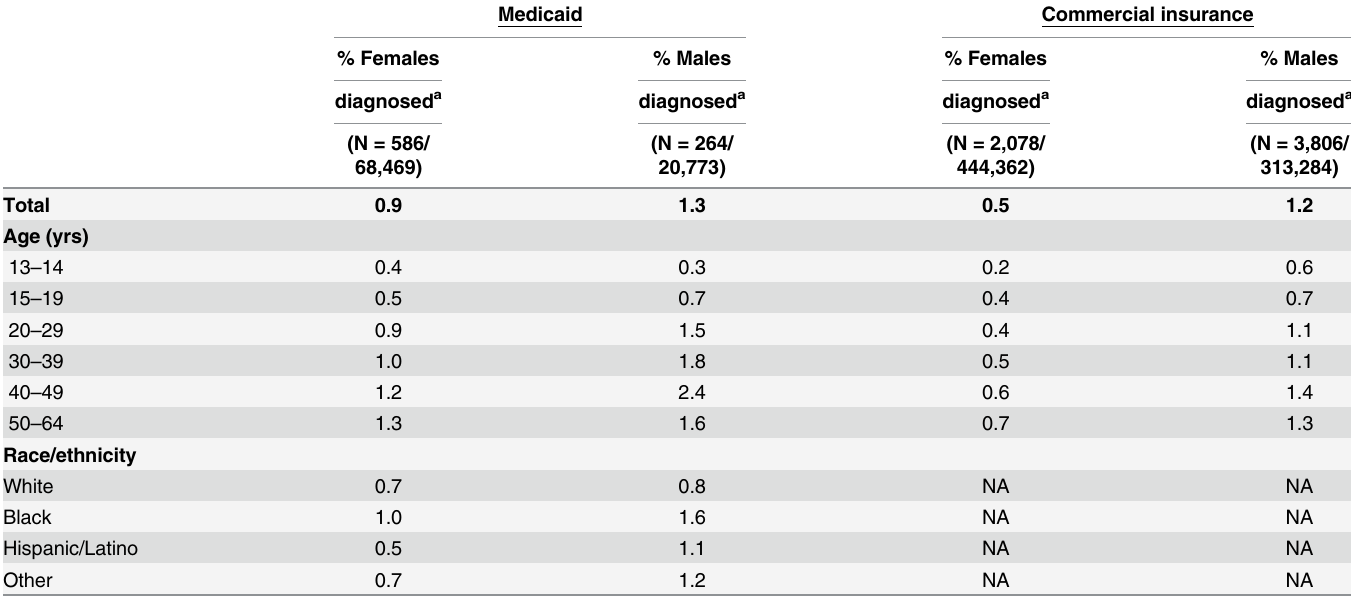
Table 4. HIV diagnoses by demographic characteristics and type of healthcare coverage among females and